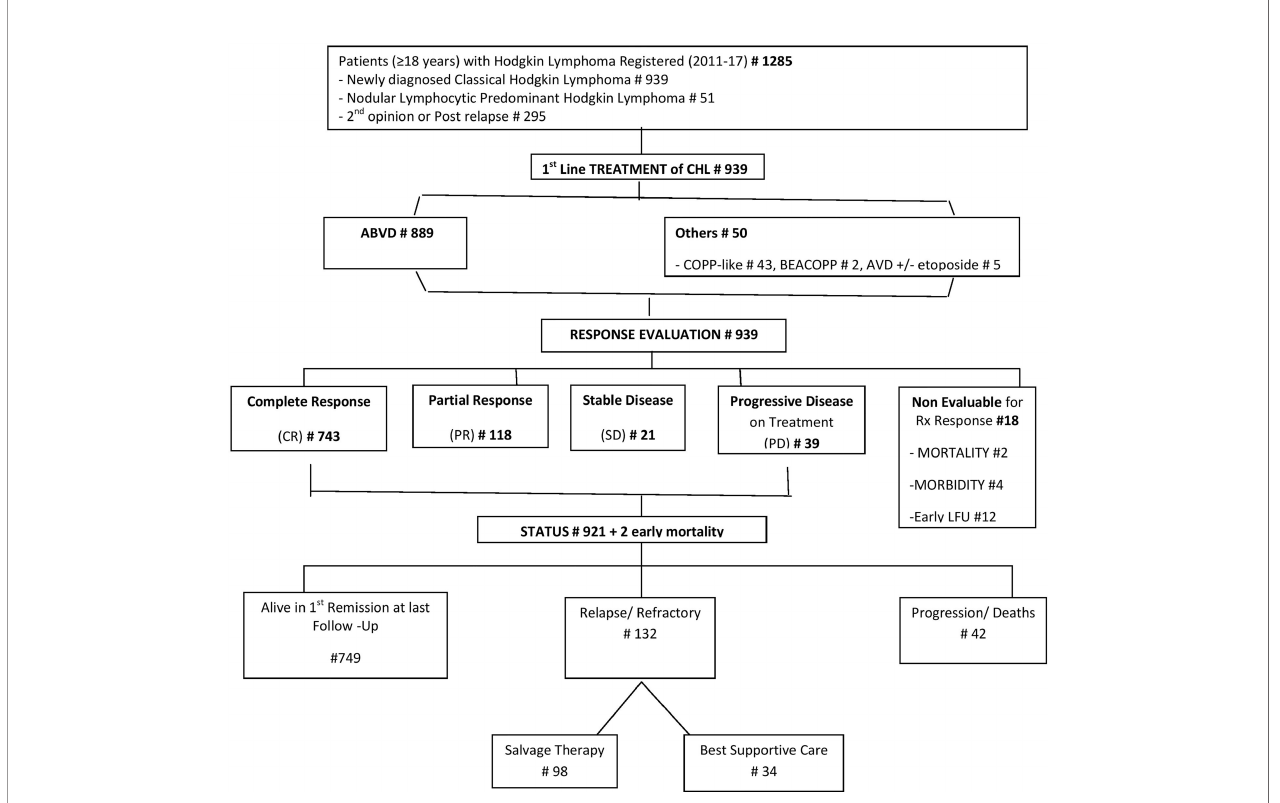
FIGURE 1 | Consort